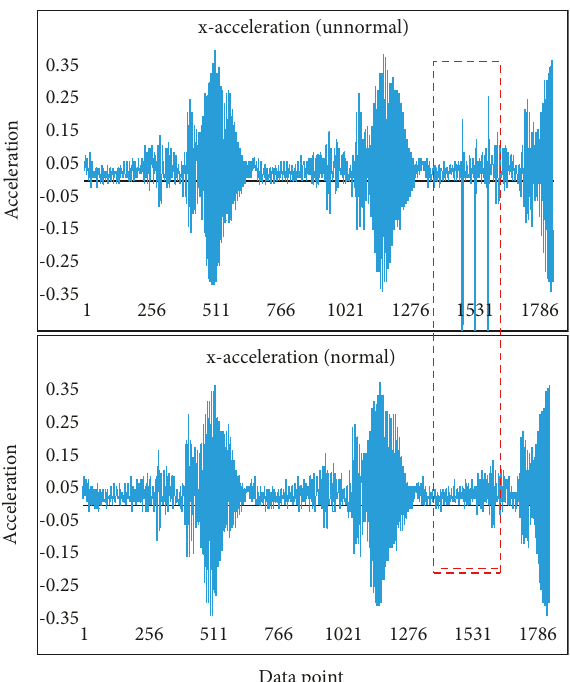
Figure 9: Time-domain distribution of the original